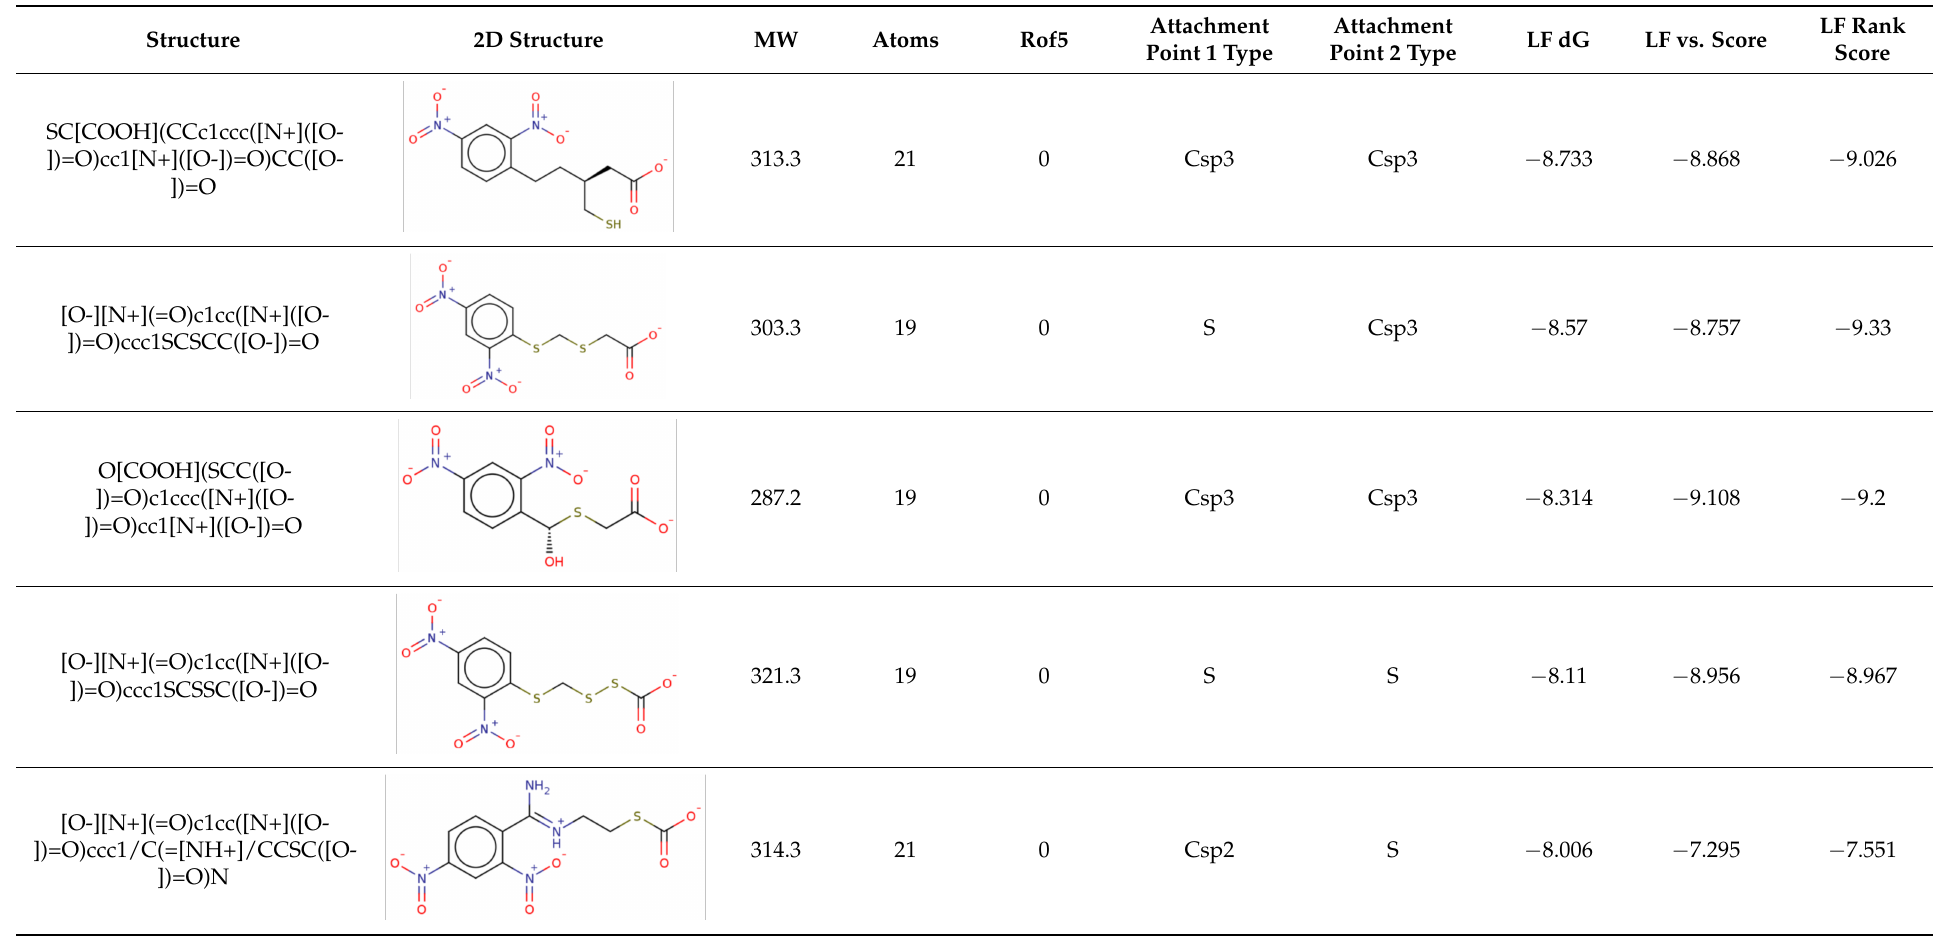
Table 3. The modified top five compounds from RJC02337 {4-(2,4-Dinitroanilino) butanoate} obtained by bio-isosteric replacements, their structure and the binding energy.